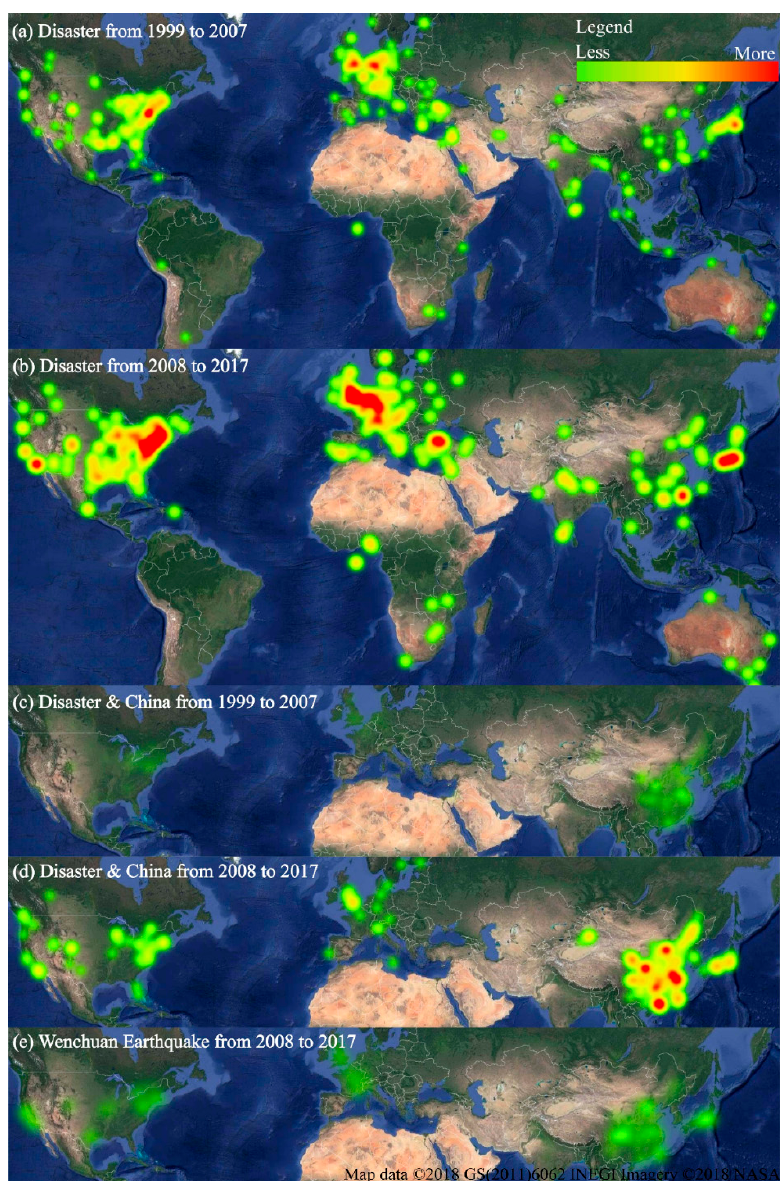
Figure 3. Geographical hotspots of publications related to the “Disaster” topic generated by Google Earth. ( a ) and ( b ) are the spatial distributions of disaster research throughout the world during two periods: 1999–2007 and 2008–2017, respectively. ( c ) and ( d ) are similar to ( a,b ) for the “ Disaster & China” topic. ( e ) The spatial distribution of the studies related to the “Wenchuan Earthquake” over the last 10 years.